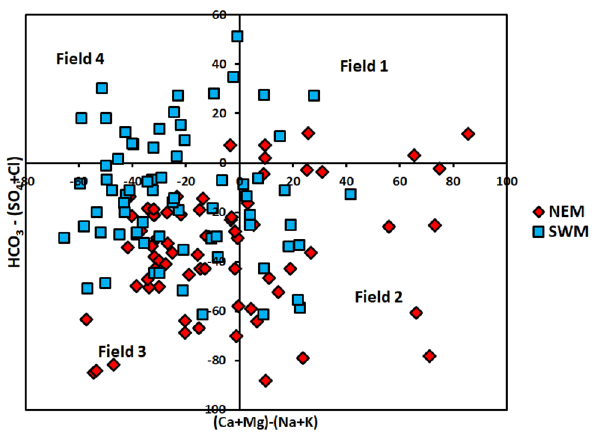
Fig. 10 Geochemical process evaluation plot for groundwater sam- ples (after Chadha [82])